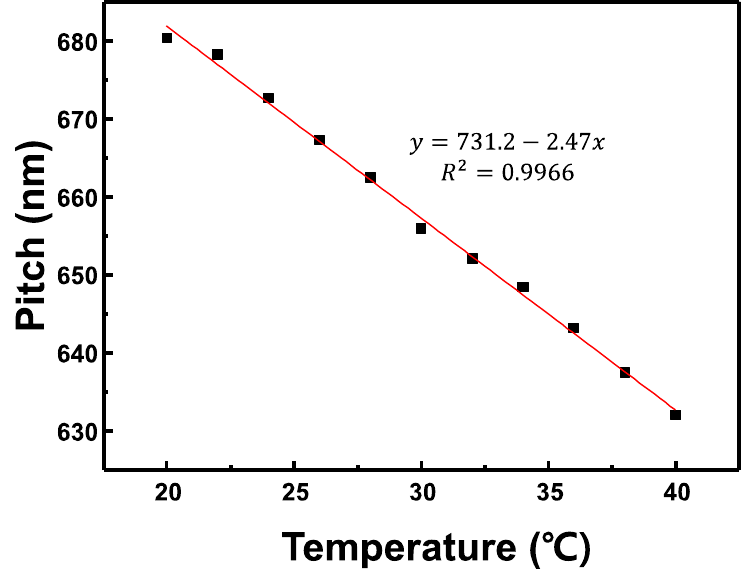
Figure 9. Variation of the pitch of the CLC cell according to the temperature calculated from the refractive indices in Figure 8.